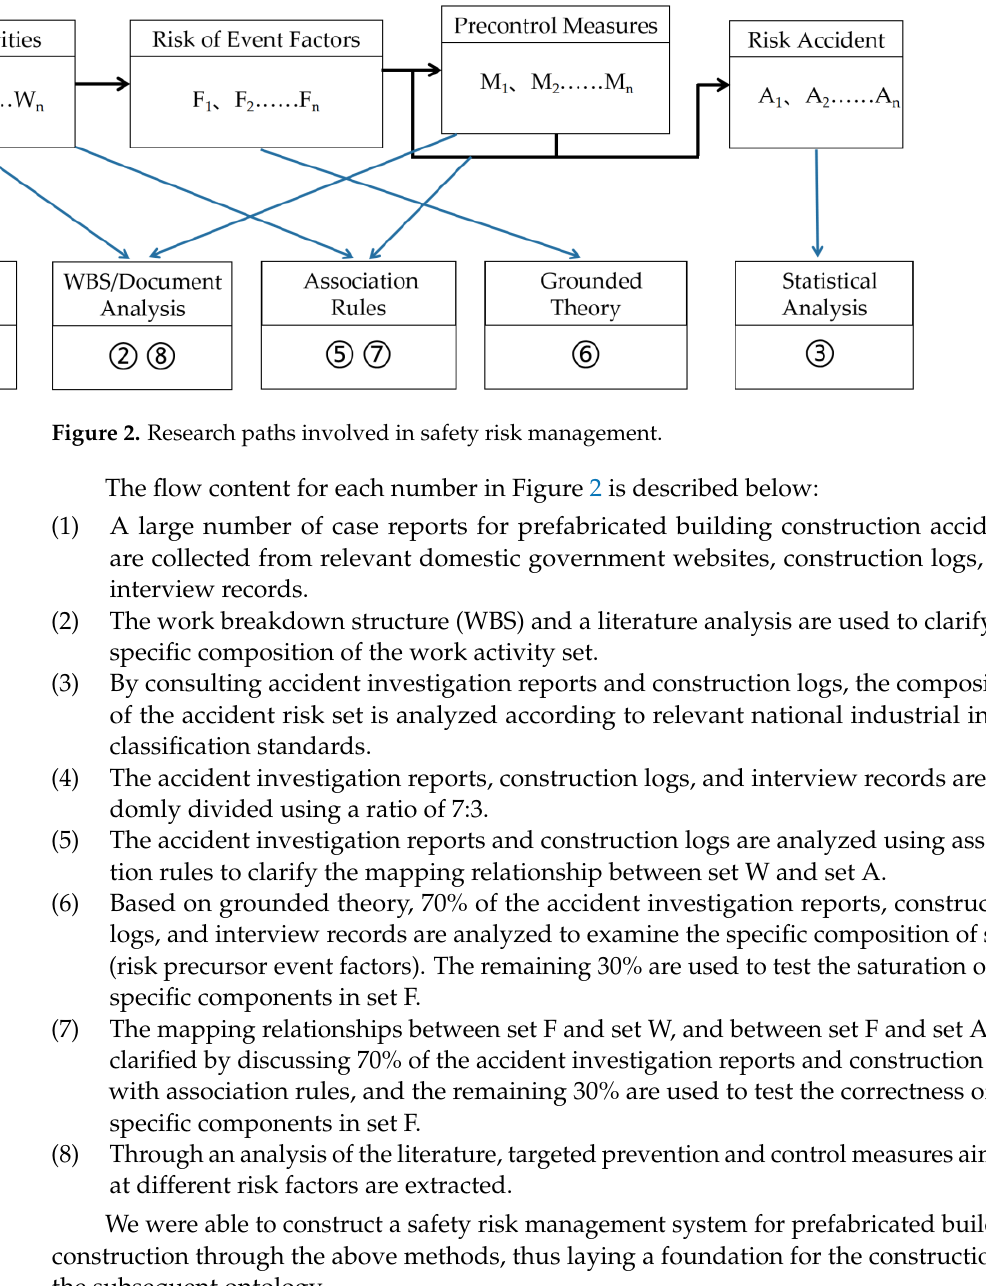
Figure 1. Research framework.